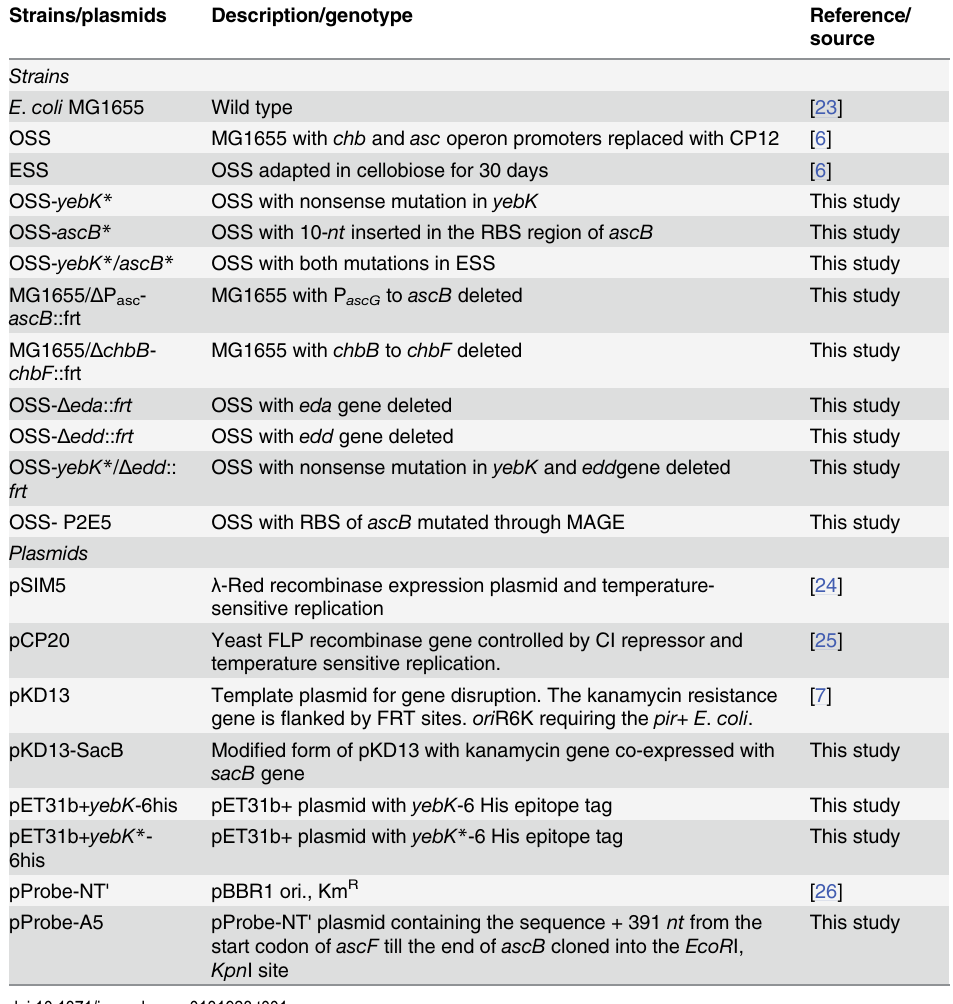
Table 1. Bacterial strains and plasmids used in this